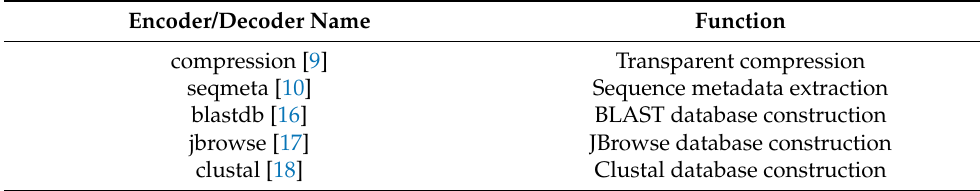
Table 1. Available encoders/decoders provided by